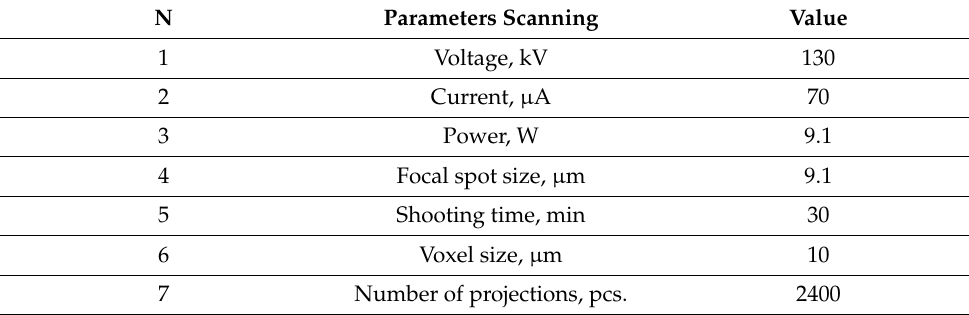
Table 2. Parameters scanning of